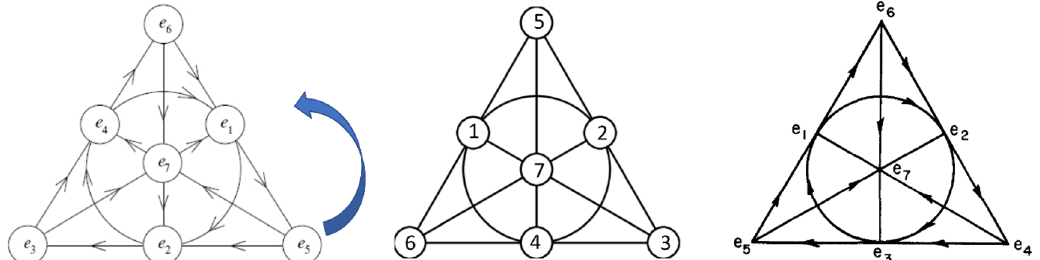
Figure 21 . An oriented Fano plane in [29] for octonions in [20, 21] is the starting point at the very left of the figure. We rotate is so that the lower left corner becomes the upper vertex of the triangle, this gives the Fano plane in the middle. The orientation of all lines remains the same. The Fano plane at the right is the one taken from [23]. It is clear that relabeling the indices as 3 ↔ 4 , 5 ↔ 6 , we can bring the Fano plane in the middle to the one on the